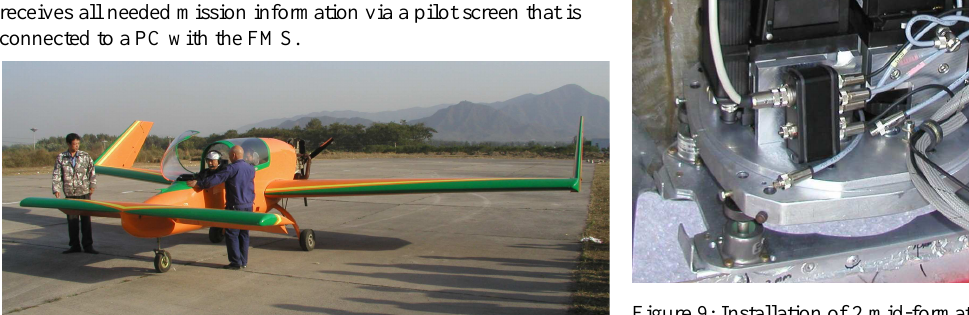
Figure 9: Installation of 2 mid-format cameras and AeroDiDOS (here FSAS IMU) for